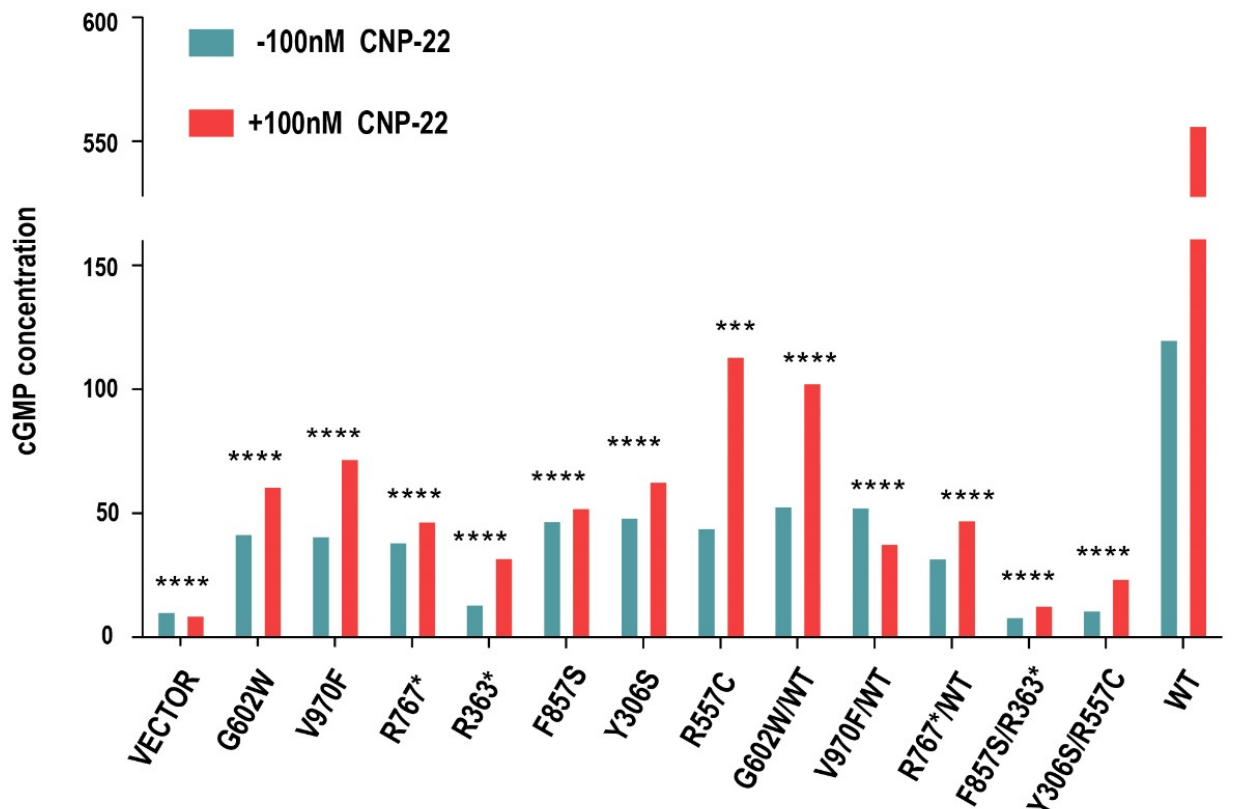
Figure 3. Impaired cyclic guanosine monophosphate (cGMP) production by natriuretic peptide receptor 2 ( NPR2 ) mutations. Mutant NPR2 cells are less effective in producing cGMP. Enzyme-linked